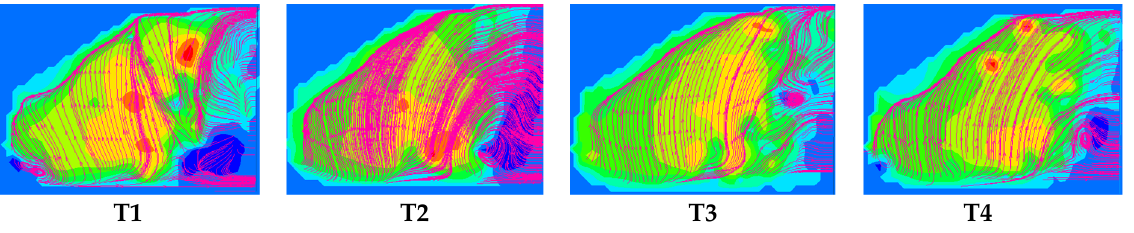
Figure 10. Incipient vortex conditions at low unit speeds. T1–T4 is the moment of shooting.